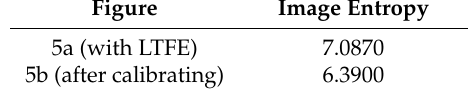
Table 2. Image entropy of Figure 5. Figure